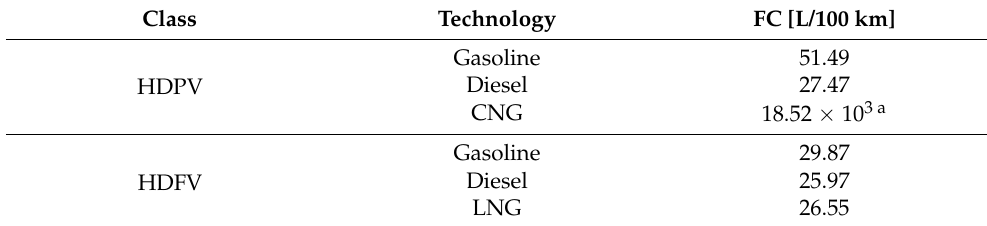
Table 3. FC of vehicles by technology